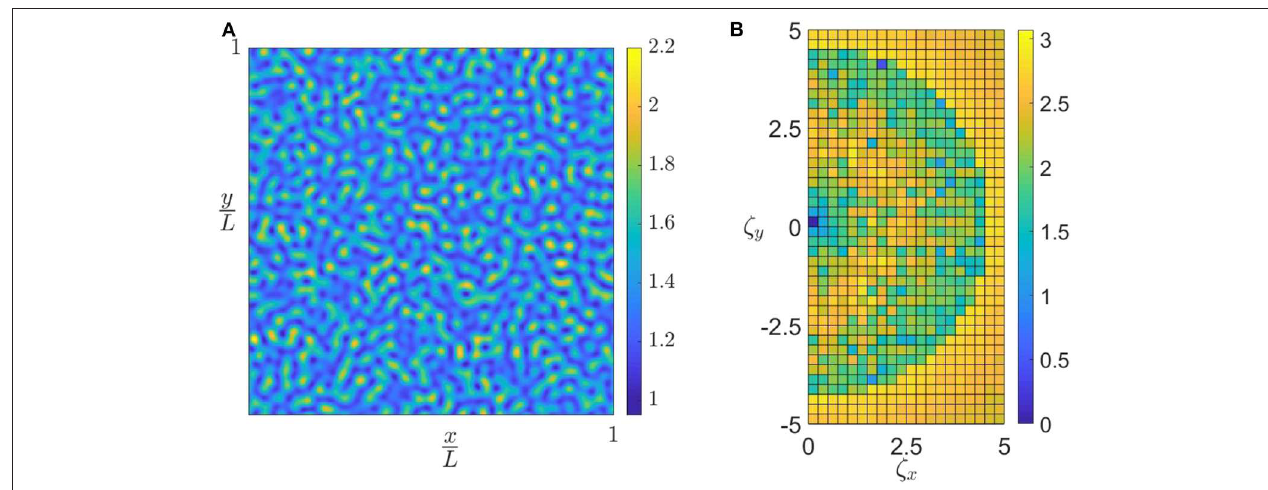
0.5 and roughness defined by ζ 1 =